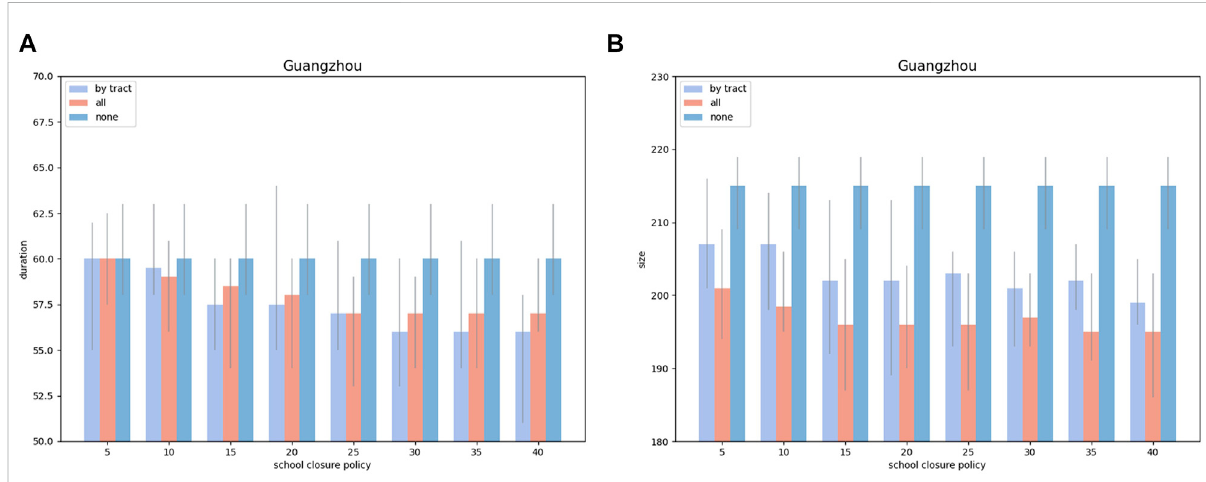
FIGURE 6 Effect of suspending classes of schools. Longer duration of school closure denotes more severe NPIs. Light blue pillars represent policies enforced by the tract, red pillars represent policies enacted by all tracts and blue pillars represent the case without school closure. We take the total number of infections (A) and the duration of the epidemic (B) as an evaluation index. The error bars represent the 95% CI for the simulation